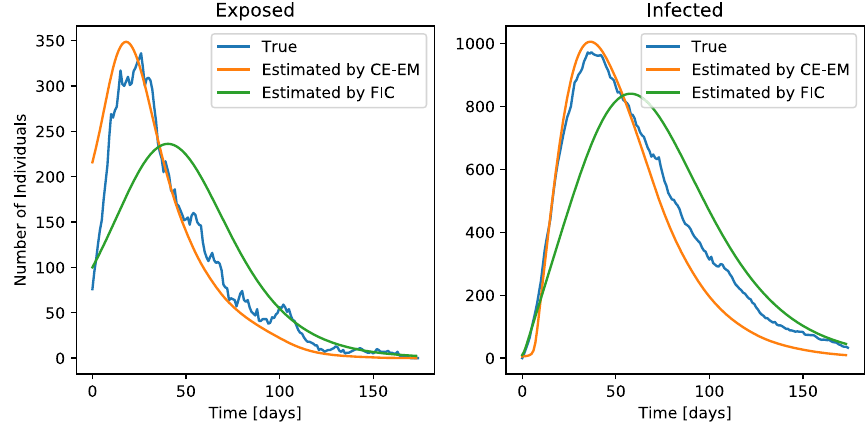
Figure 6. Estimation of unobserved quantities by CE-EM and FIC baseline methods when fitting a SEIRD model to simulated data. (Left) Estimation of the number of exposed individuals. (Right) Estimation of the number of infected individuals. The estimates made by CE-EM align almost perfectly with ground truth in terms of peak intensity, peak height, and curve shape, while those of the FIC baseline do